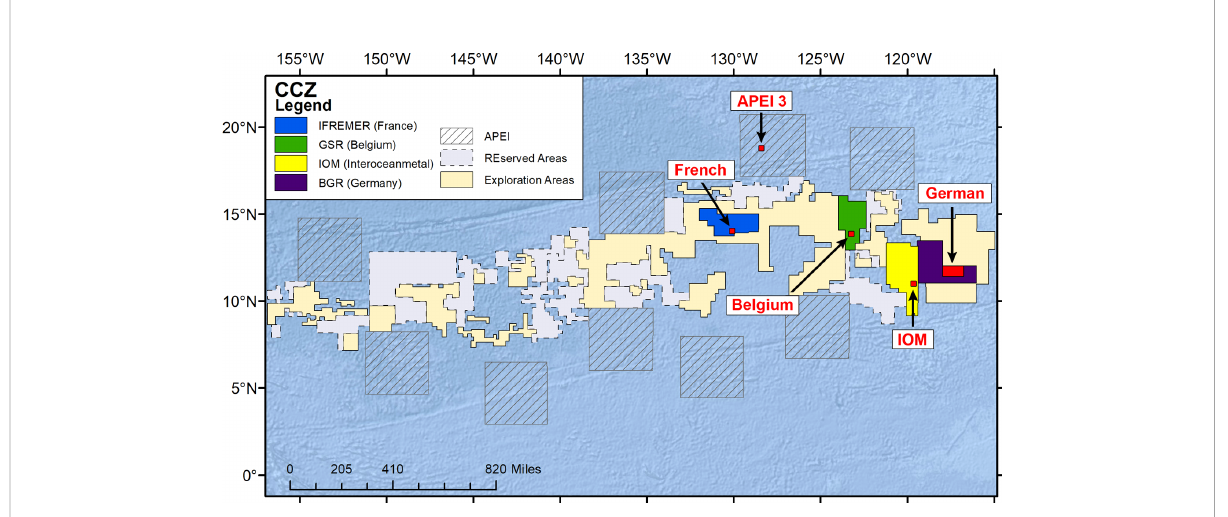
FIGURE 1 Map of the Clarion-Clipperton Zone showing the general location of sampling sites in the German, IOM, Belgium, and French areas and